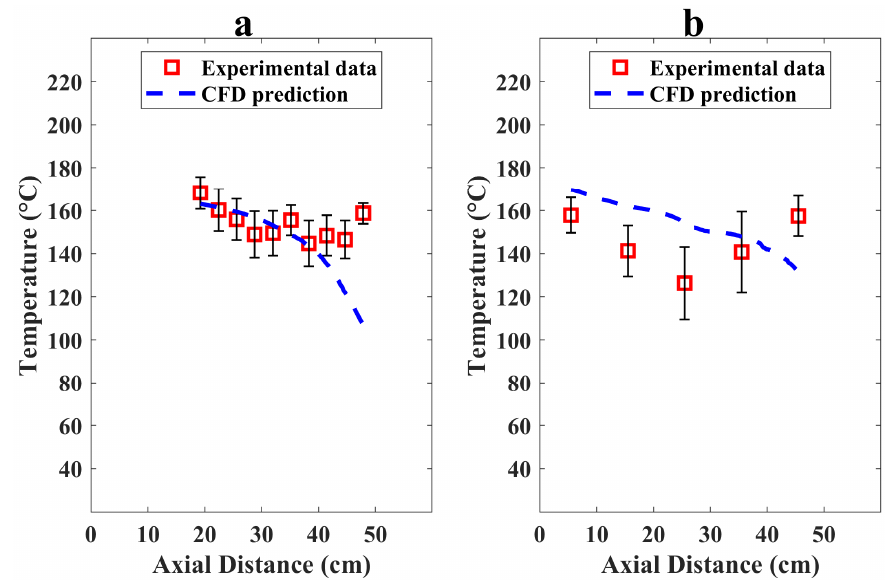
Figure 4. Comparison of experimental temperature measurements and CFD model predictions, at the single axial probe ( a ), and at five radial probes ( b ).